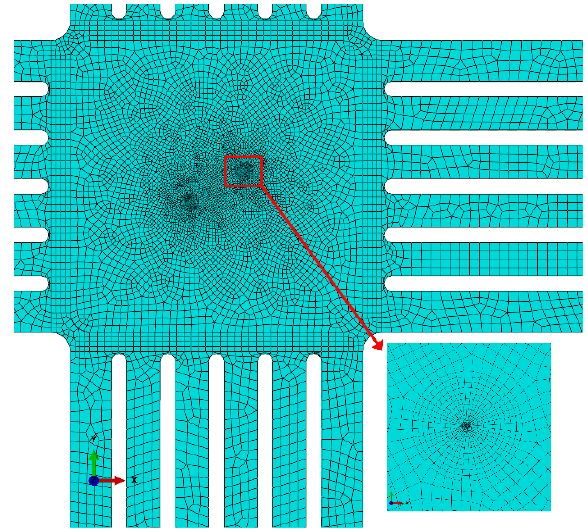
Figure 3. Finite element model of cruciform specimen with mesh and refined mesh near crack.